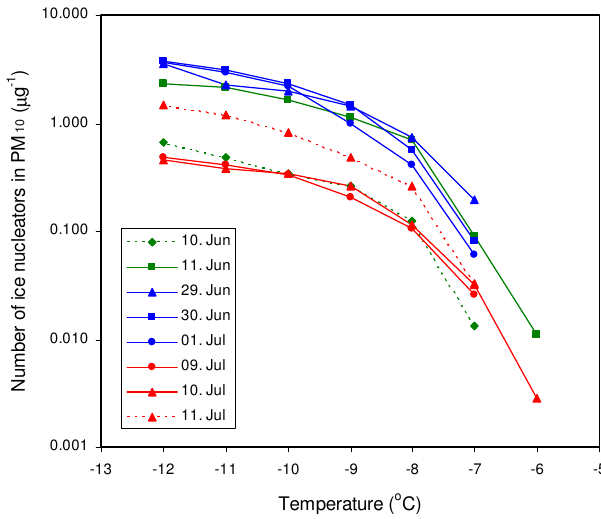
Fig. 2. Number of IN sites per unit mass of PM 10 , derived from analysis of PM 10 filters, which had been used to sample air from different origin during 24h (720m 3 ) : (blue) PM 10 originating largely from the Swiss and southern German boundary layer; (red) Saharan dust event, (broken line) with considerable amounts of re- gional (Swiss) boundary layer air; (green) North Italian influence, (broken line) possibly affected by precipitation